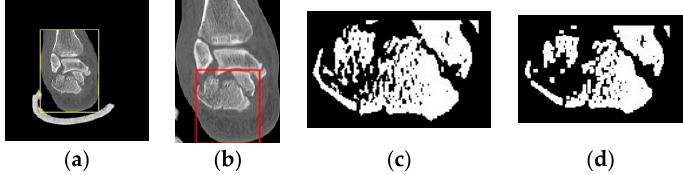
Figure 8. Algorithm for determining the type of calcaneus fracture in the coronal and transverse image.